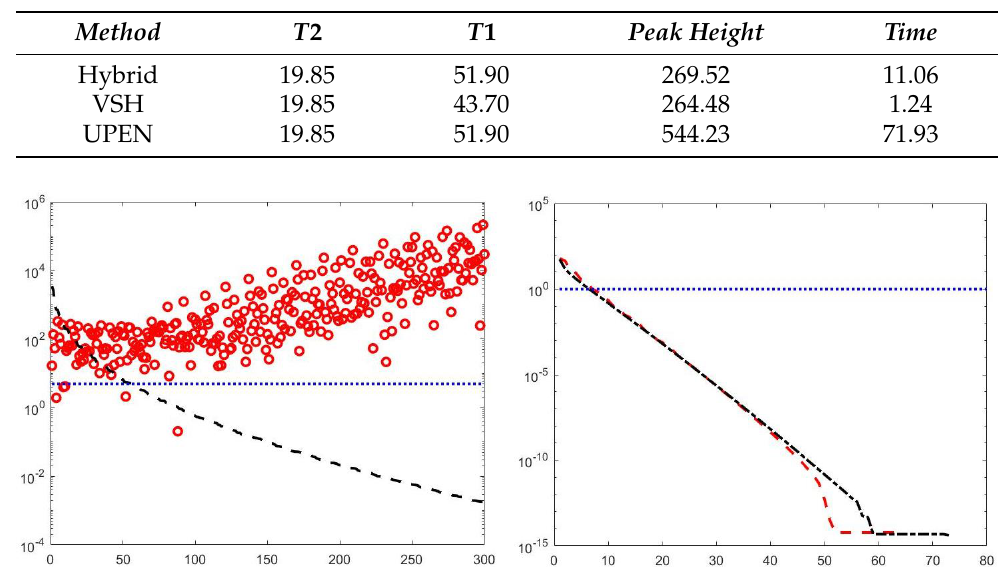
Table 3. Location and height of the peak in the restored distribution and required execution time in seconds.